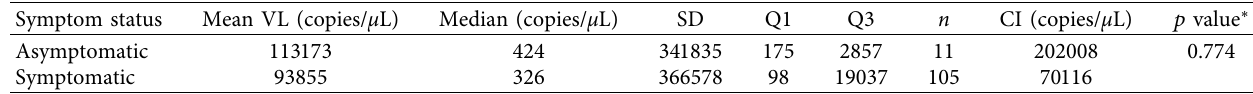
Table 5: Correlation between the presence of symptoms and SARS-CoV-2 viral load in 116 children and adolescents. Symptom status Mean VL (copies/ μ L)